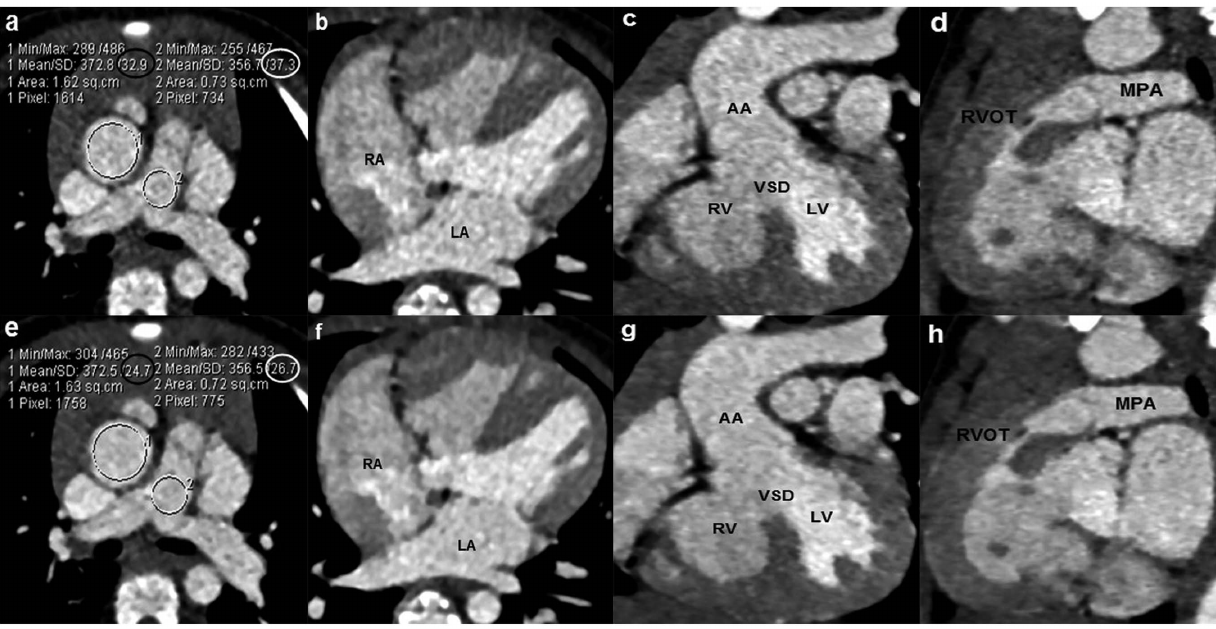
Figure 1. An 18-month boy with the diagnosis of Tetralogy of Fallot and atrial septal defect. The sequential DSCT angiography was performed with 70 kV and 100 mAs/rotation (effective radiation dose, 0.32 mSv). Axial images (a,e), multiplanar reformatted (MPR) images (b–d, f–h) using filtered back projection (FBP) algorithm (a–d) and sinogram affirmed iterative reconstruction (SAFIRE) algorithm (e–h) are shown. Image noise of the ascending aorta and pulmonary trunk which is expressed as the standard deviation (SD) of the attenuation (HU) in the regions of interest is significantly reduced in images reconstructed by SAFIRE (black and white circles in f) in contrast to FBP black and white circles in a). MPR images reconstructed with SAFIRE algorithm exhibit substantially reduced image noise and the improved image quality compared with images obtained with FBP. LA = left atrium, RA = right atrium, RV = right ventricle, LV = left ventricle, VSD= ventricular septal defect, AA = ascending aorta, RVOT= right ventricular outflow tract, MPA = main pulmonary artery.